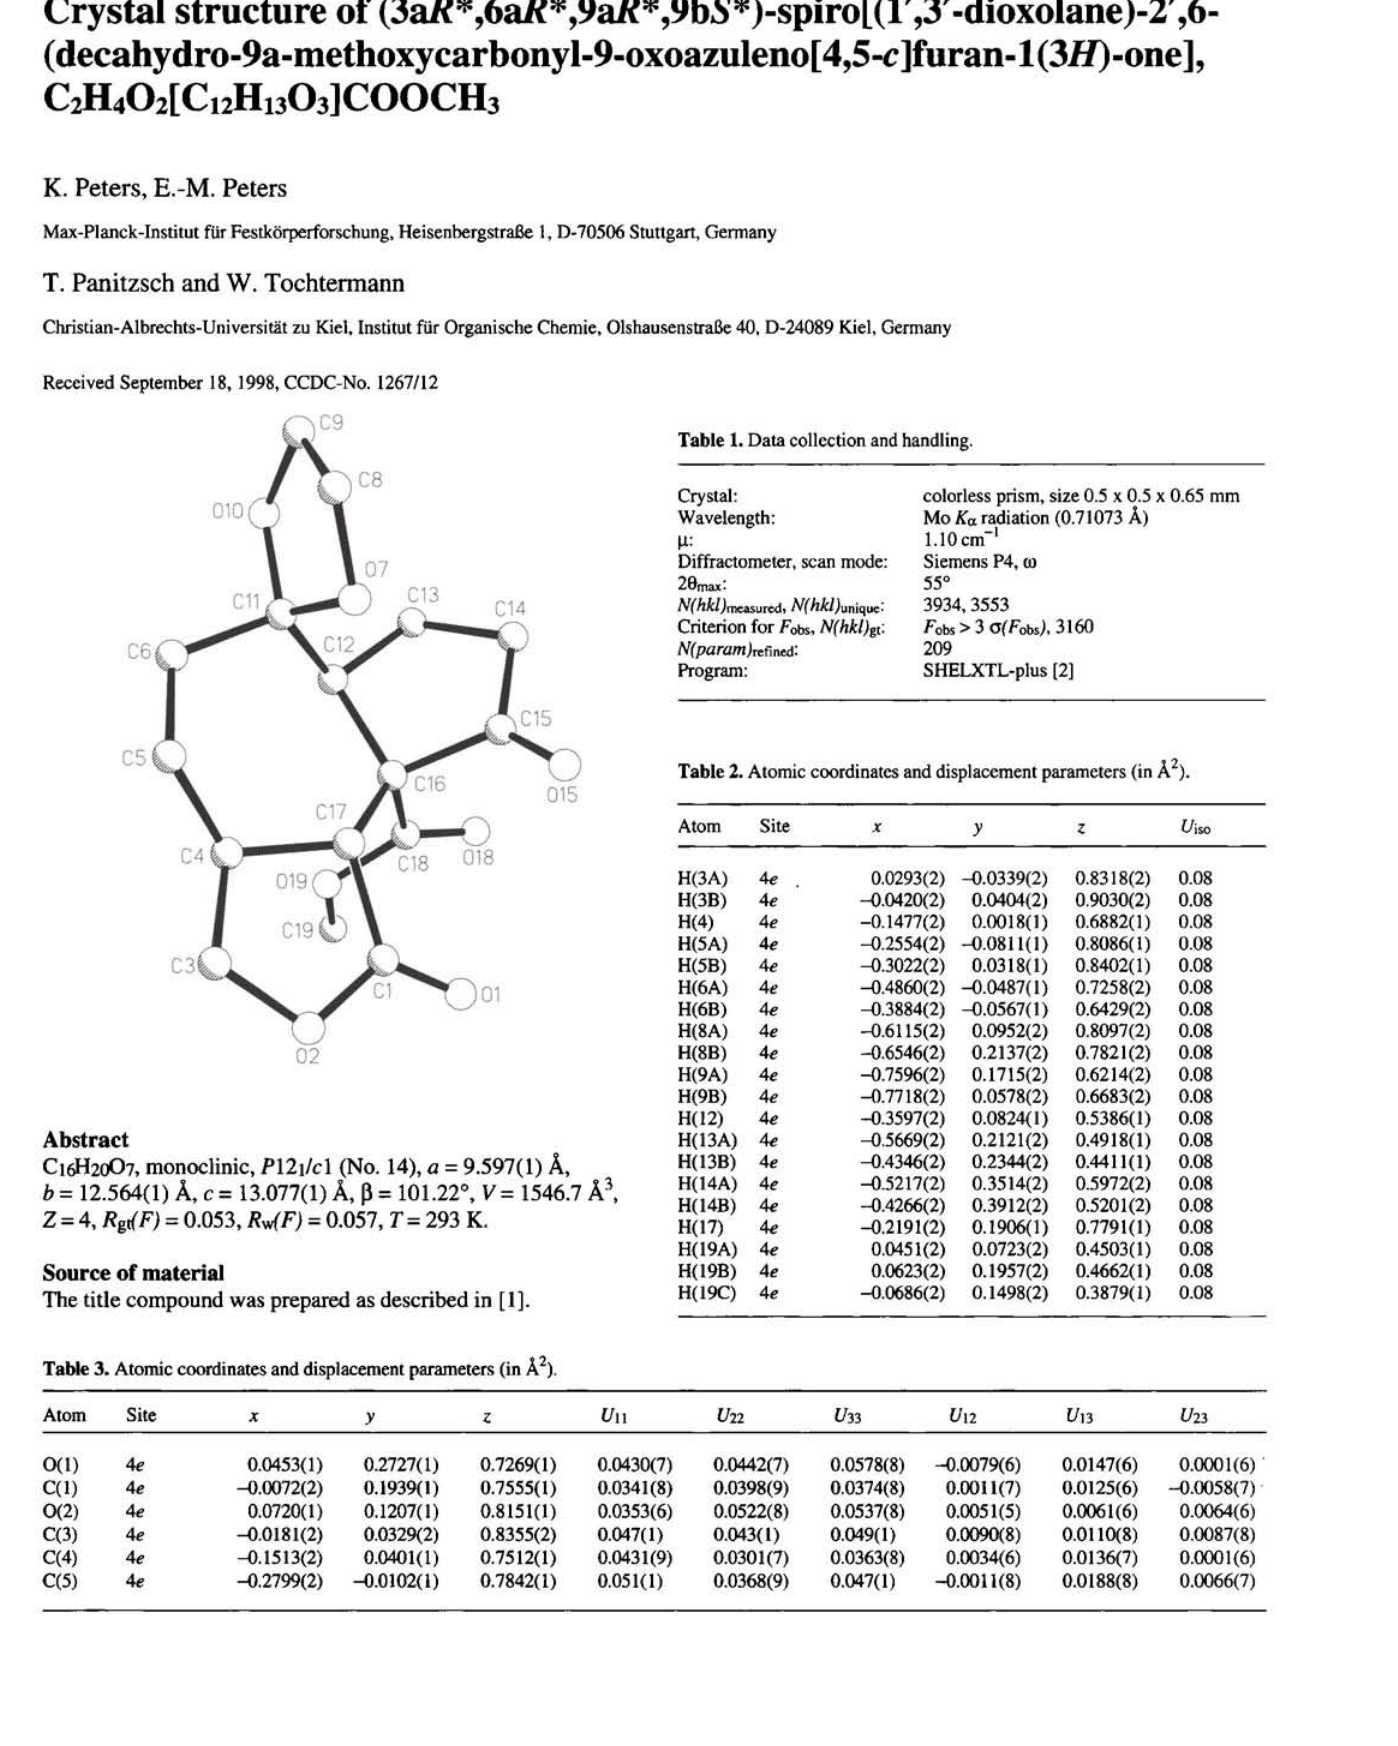
Table 3. Atomic coordinates and displacement parameters (in Â 2 ).